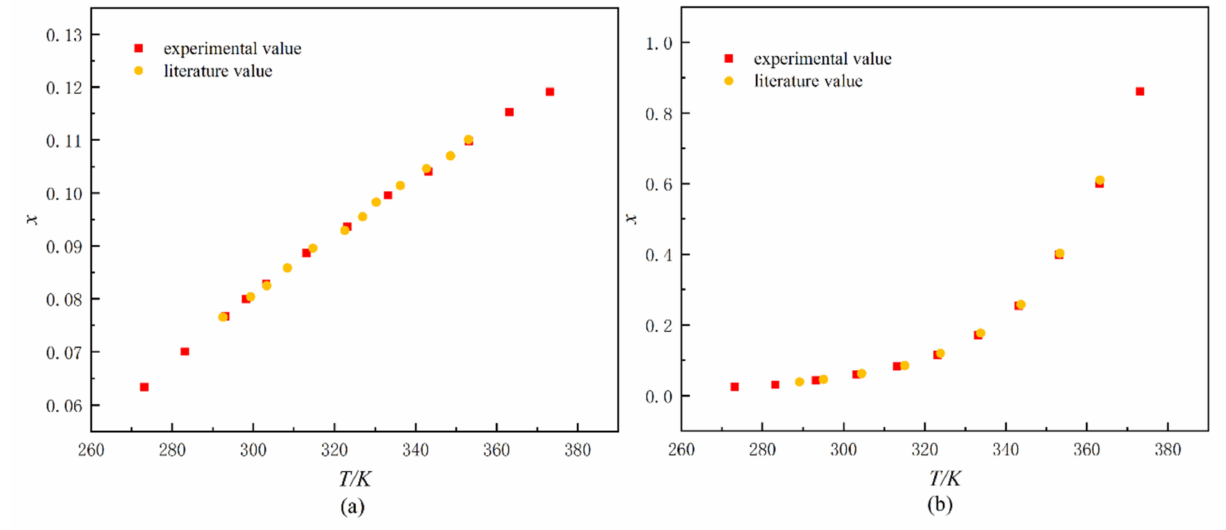
Figure 14. The solubility of potassium chloride in water ( a ) and the solubility of benzoic acid in water ( b